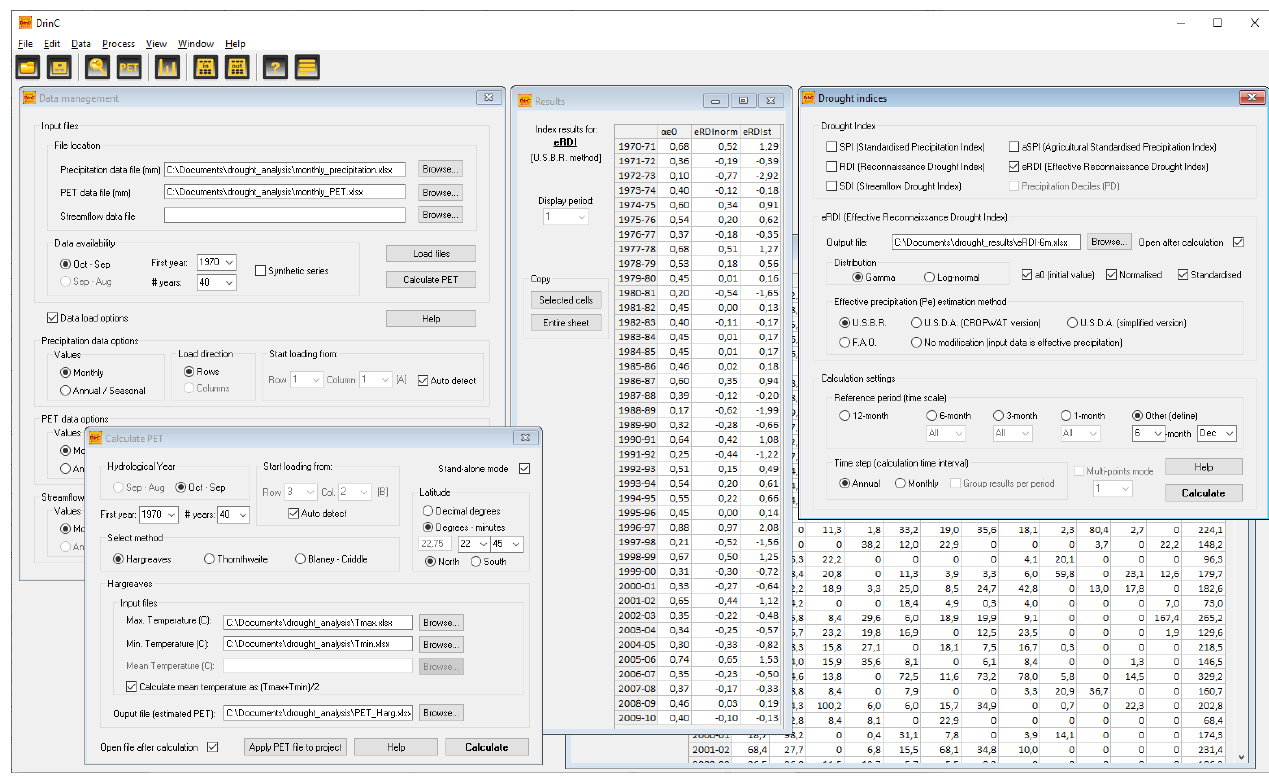
Figure 1. The graphical user interface of DrinC software.